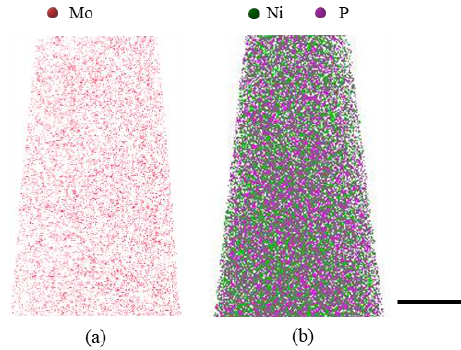
Figure 4. 3D atomic probe tomography (APT) results of ( a ) as-deposited Ni-14.2 at.% Mo (red dots stand for Mo atoms) and ( b ) Ni-8.5 at.% P (green for Ni with purple P) exhibiting homogeneous distribution of both solute and solvent atoms (Ni, Mo and P). Scale bar in the figure is 20 nm.